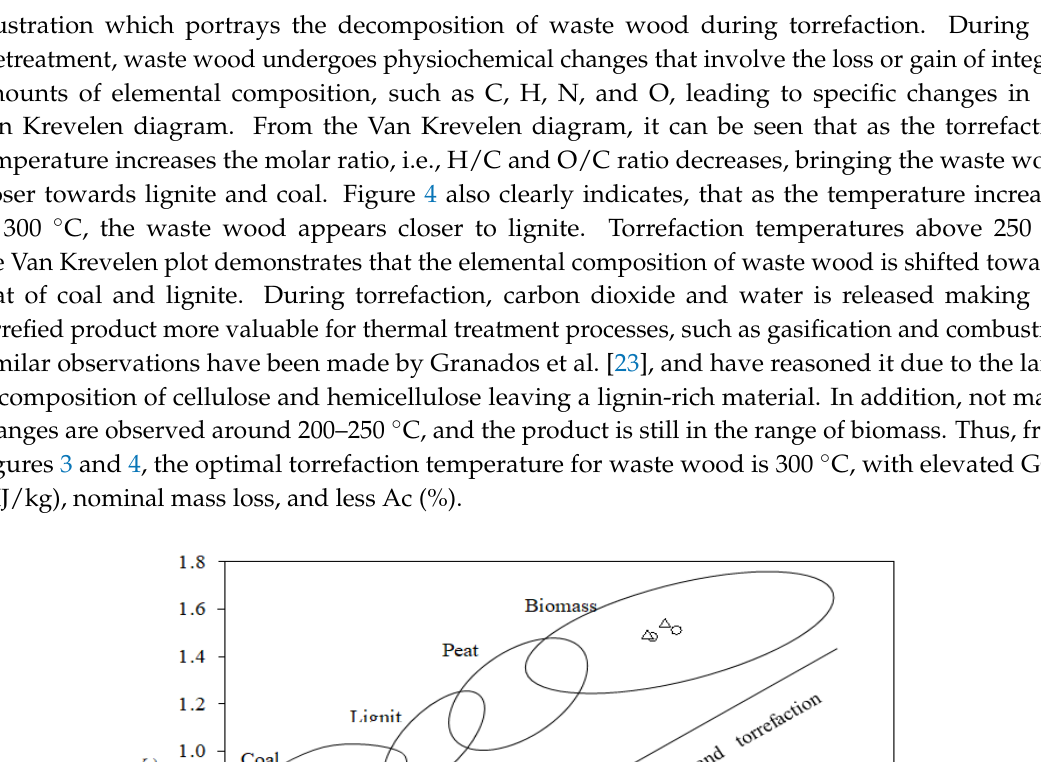
( b ) Figure 5. CHO index values of ( a ) biomass feedstocks (data adapted from Reference [21]) ( b ) waste wood with respect to torrefaction temperature. 3.3. Effect of Residence Time on Torrefaction Parameters